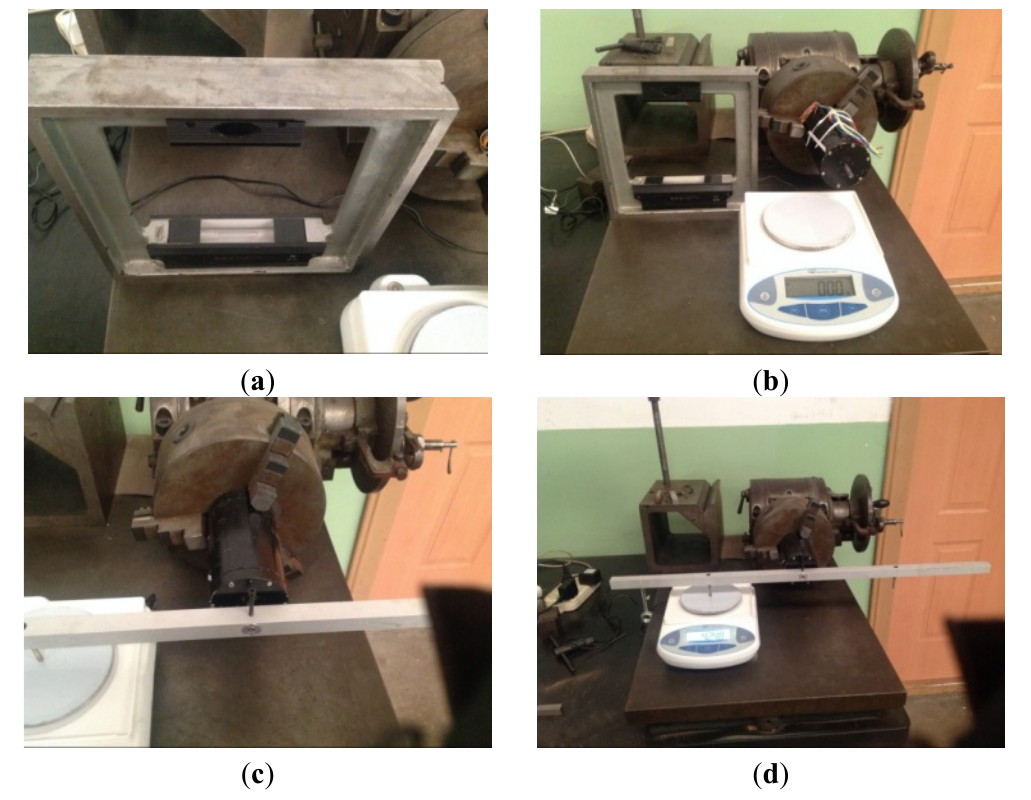
Figure 15. The platform for measuring the cogging torque: ( a ) Frame level; ( b ) Lathe and digital gauge; ( c ) Balance beam; ( d ) All